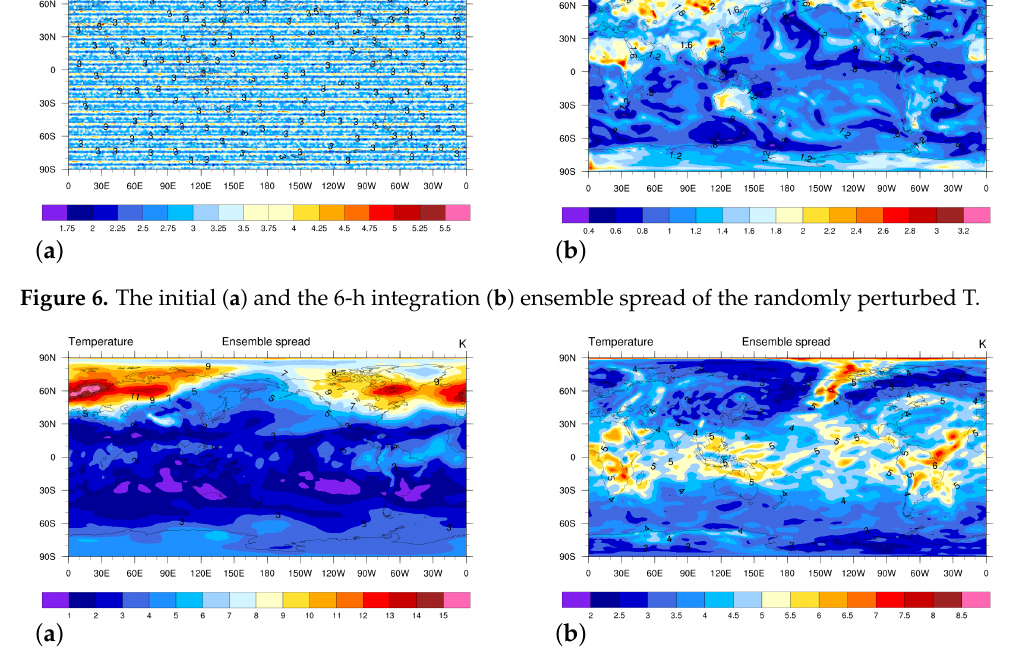
Figure 7. The initial ( a ) and the 6-h integration ( b ) ensemble spread of the MEOF perturbed